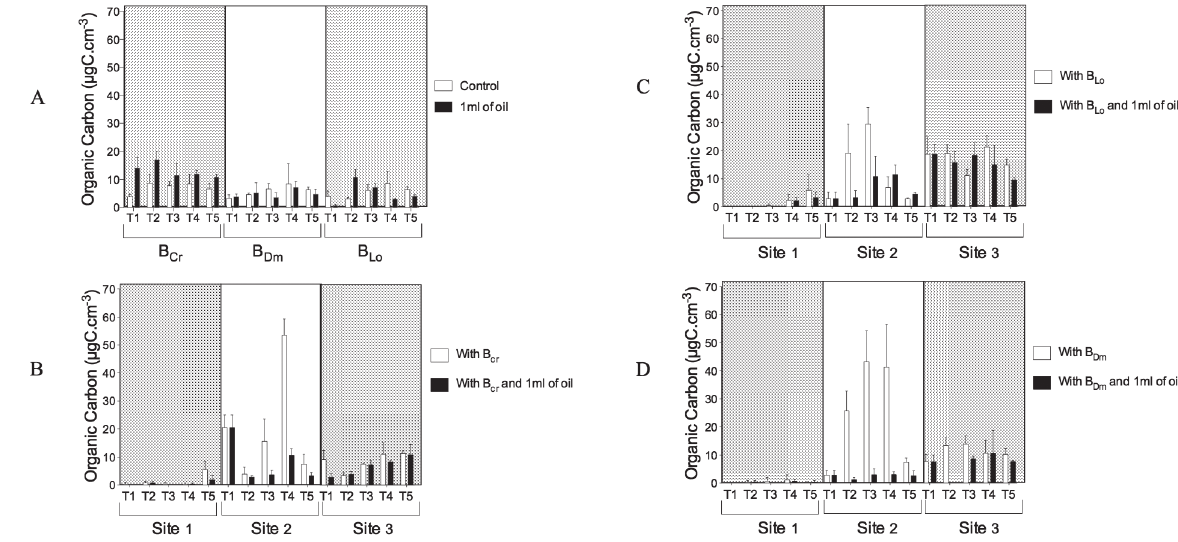
Figure 3 - Biomass from Bacterial consortia sampled from seaweed under influence of protists sampled from Guanabara Bay and oil. A- Control; B- With B